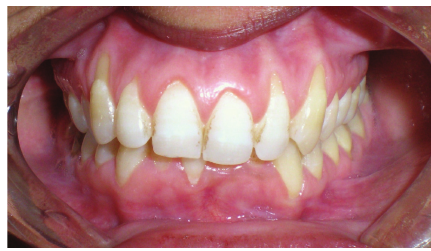
Figure 3: Partial thickness flap elevated.